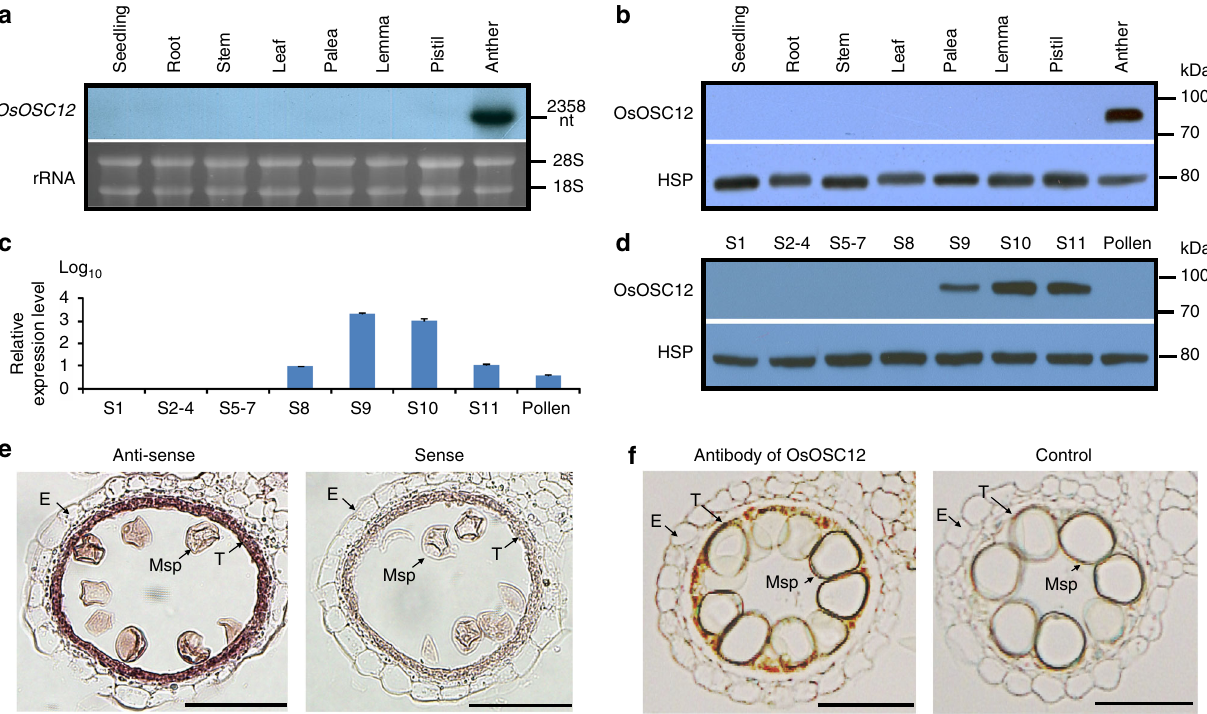
Fig. 1 Transcription and expression of OsOSC12 . a , b Tissue speci fi city as revealed by northern and western blotting. c , d Temporal pro fi les during anther development, as shown by real-time PCR and western blotting. S1 to S11 correspond to the stages of anther development as described 15 . The values are presented as means ± s.e., n = 3. e The localization of OsOSC12 mRNA at S9. Hybridization with sense OsOSC12 transcript provided the negative control. f Immuno-localization of OsOSC12 at S10. Hybridization with blocking buffer was used as the negative control. The negative controls for northern and western blotting experiments were, respectively, 18S and 28S rRNA, and the rice heat shot protein Q69QQ6. E epidermis, Msp microspore, T tapetum. Scale bar, 50 μ